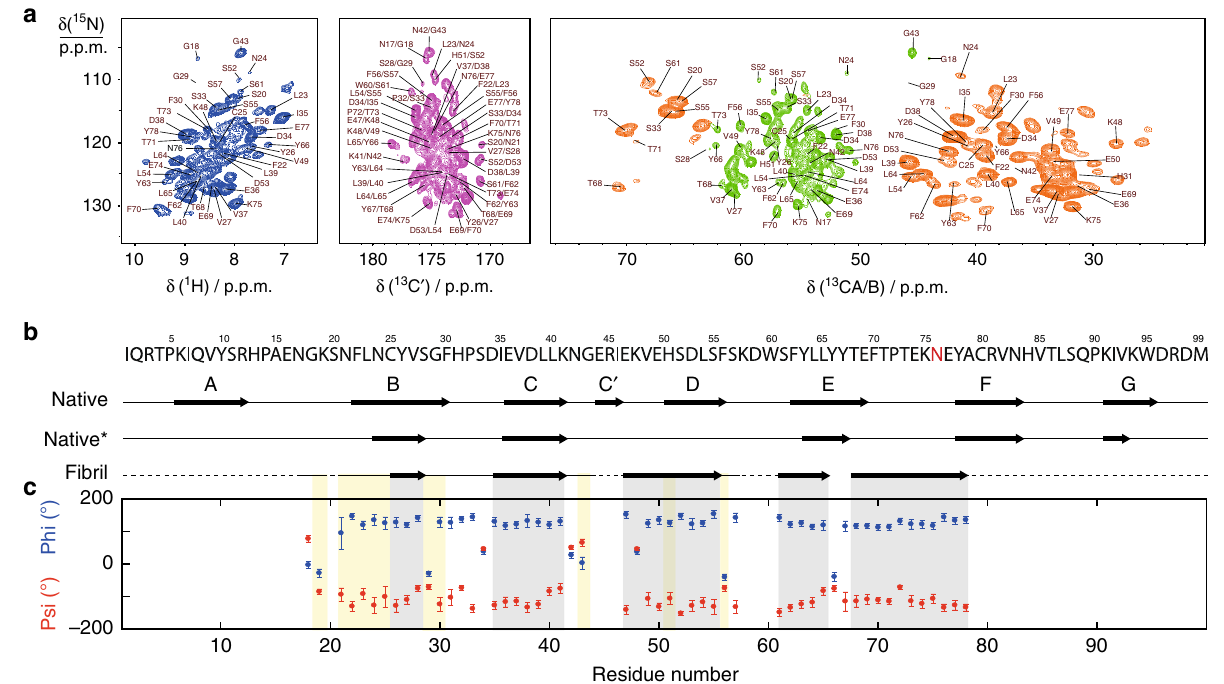
Fig. 6 Structural characterization of D76N fi brils. a Assigned 1H-15N 2D projection of (H)CANH (dark blue) correlation spectrum and 13C-15N 2D projections of (H)CONH (purple), (HCA)CB(CA)NH (orange) and (H)CANH (green) correlation spectra of [2H, 13C, 15N] D76N β 2m fi brils with 100% reprotonation at the exchangeable sites (283 K, pH 7). Spectra were recorded on a 1 GHz spectrometer at 60 kHz MAS rate. b Secondary structure prediction of D76N β 2m fi brils by TALOS-N 39 (black arrows correspond to β -strands, straight lines to loops and dashed lines to an absence of prediction). The β -strands of the native fold are depicted above the primary sequence. The secondary structures of fi brillar wt β 2m 40 are also shown for comparison. c Backbone dihedral angles phi and psi predicted by TALOS-N. The gray and yellow boxes show TALOS-N for β -strands and ambiguous predictions, respectively. Error bars (s.d.) are based on the 10 best TALOS-N database matches